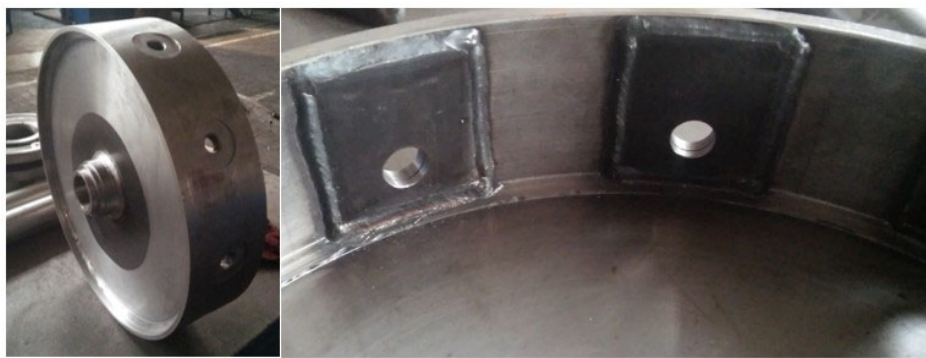
Figure 14. View of the rotor with blades sockets.